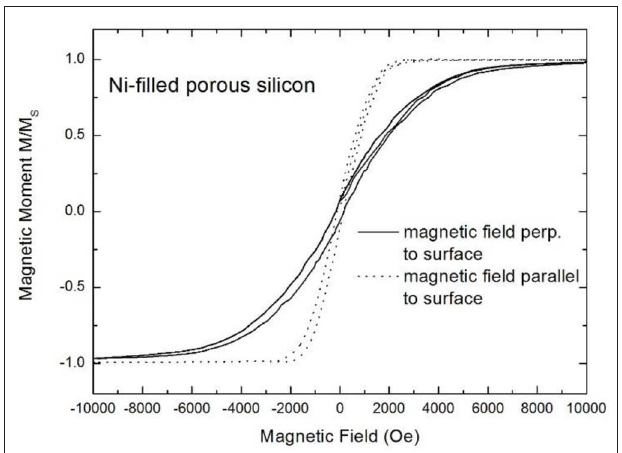
FIGURE 9 | Field dependent magnetization curves measured with an applied field parallel (dotted line) and perpendicular (solid line) to the sample surface showing that the magnetic easy axis is parallel to the surface. Granitzer et al. [ 47], with permission.